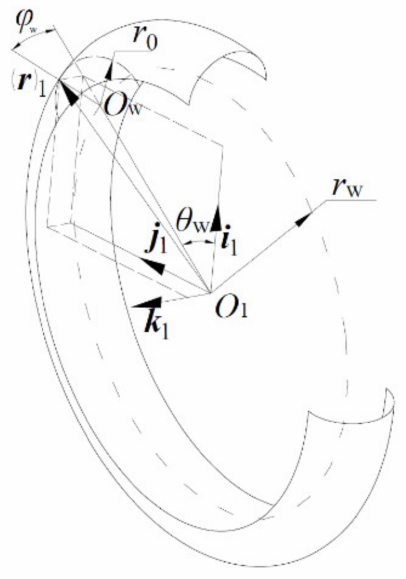
Figure 2. Diagram of the tire